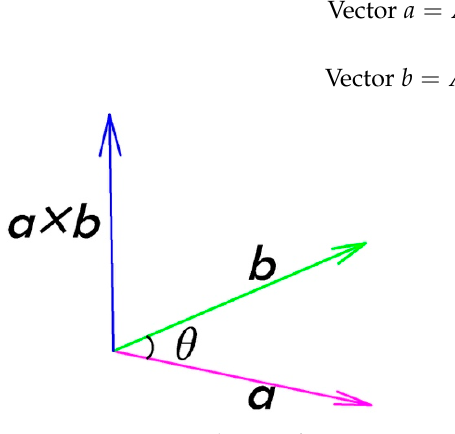
Figure 6. Vector a and Vector b .